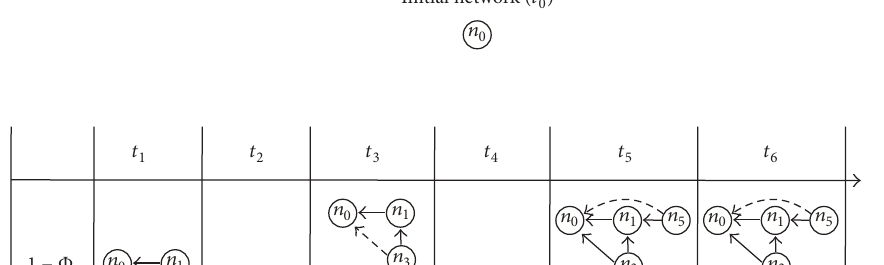
𝑡 𝑛 3 , 3 is added and it is